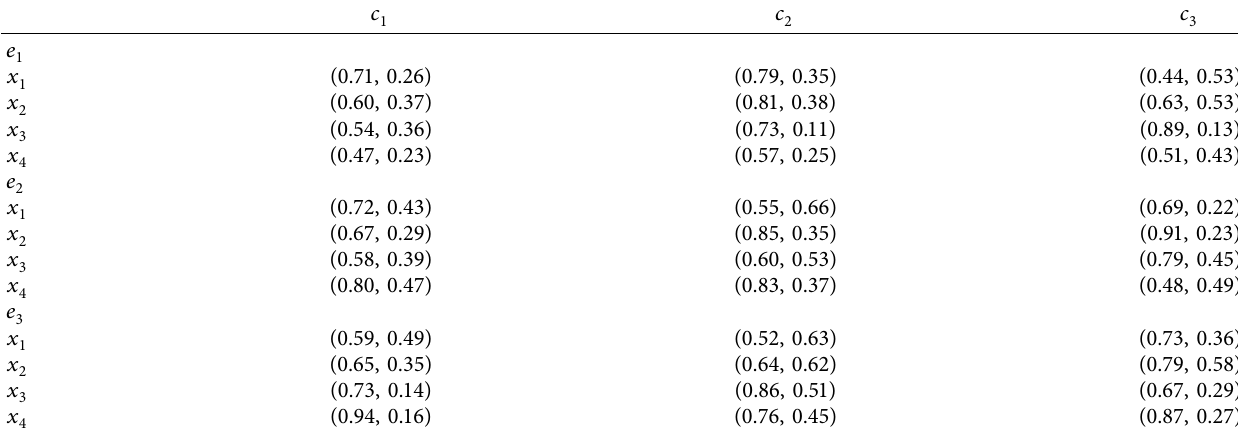
Table 1: Pythagorean fuzzy (PF) decision matrices.